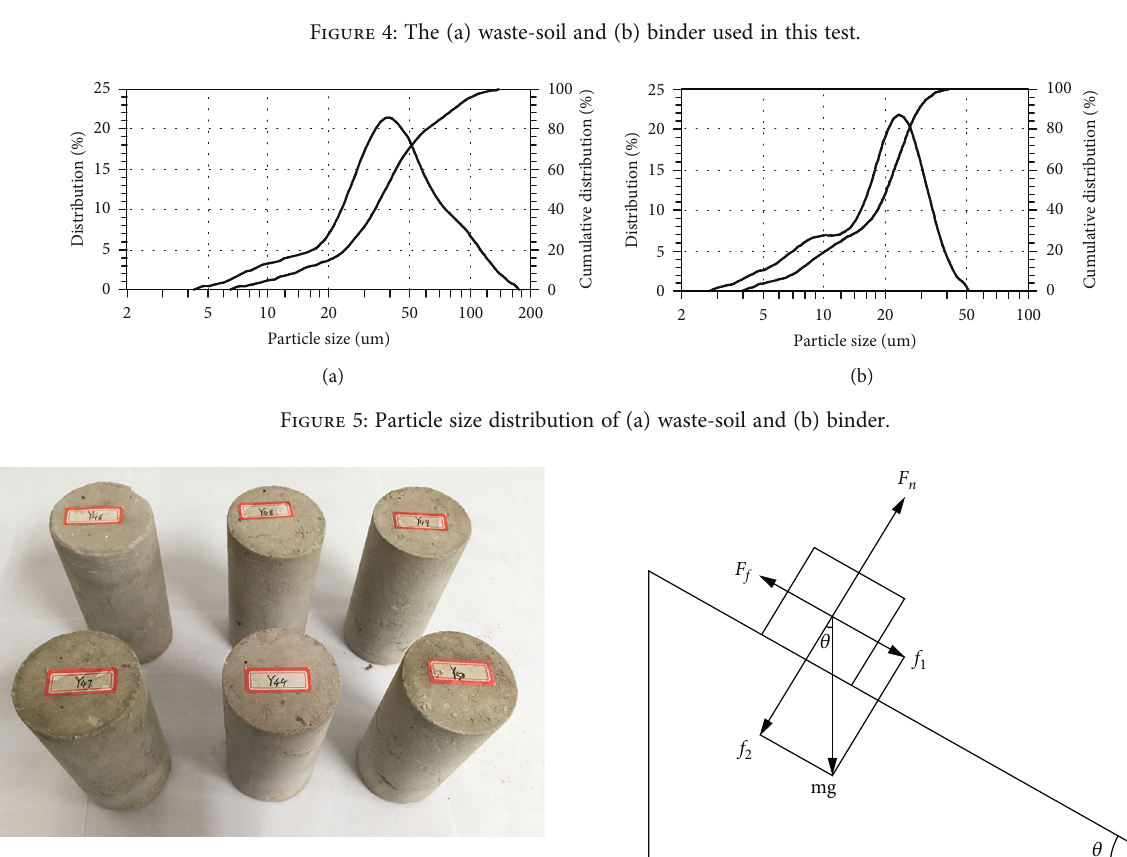
Figure 6: Samples.